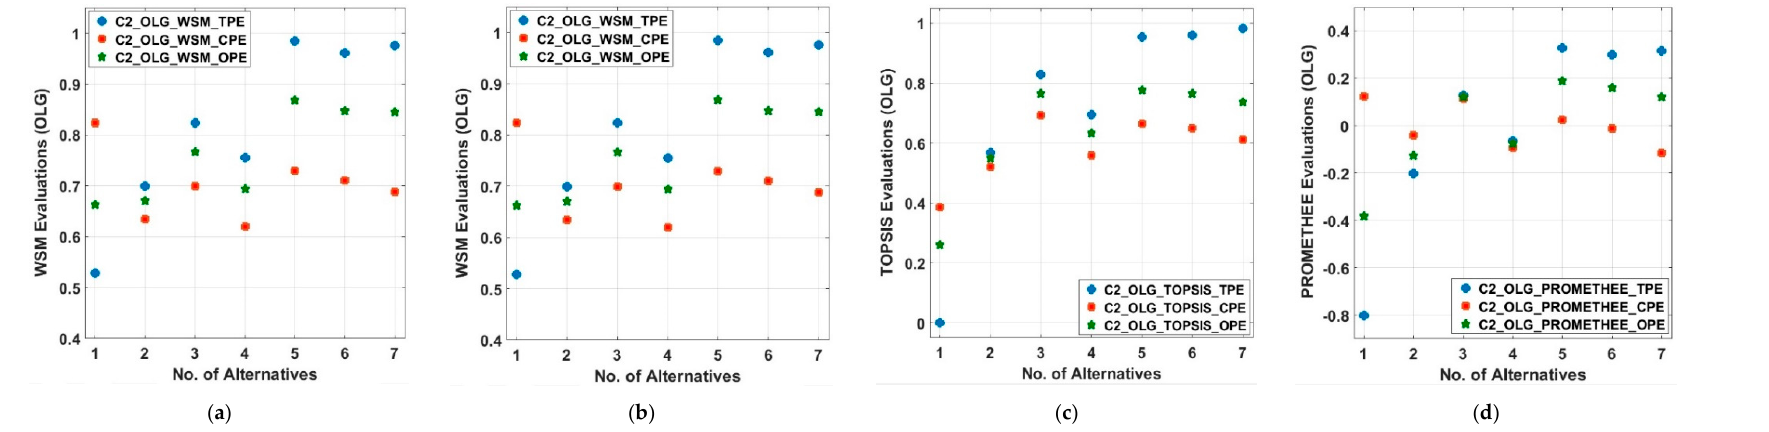
Figure 14. MCDM evaluations for C2_OLG in 33-bus MDN: ( a ) WSM scores; (b) WPM scores; ( c ) TOPSIS scores; ( d ) PROMETHEE scores. Table 24. Order of the ranks across TPE, CPE, and OPE in C2_OLG for 33-bus MDN. Evaluations